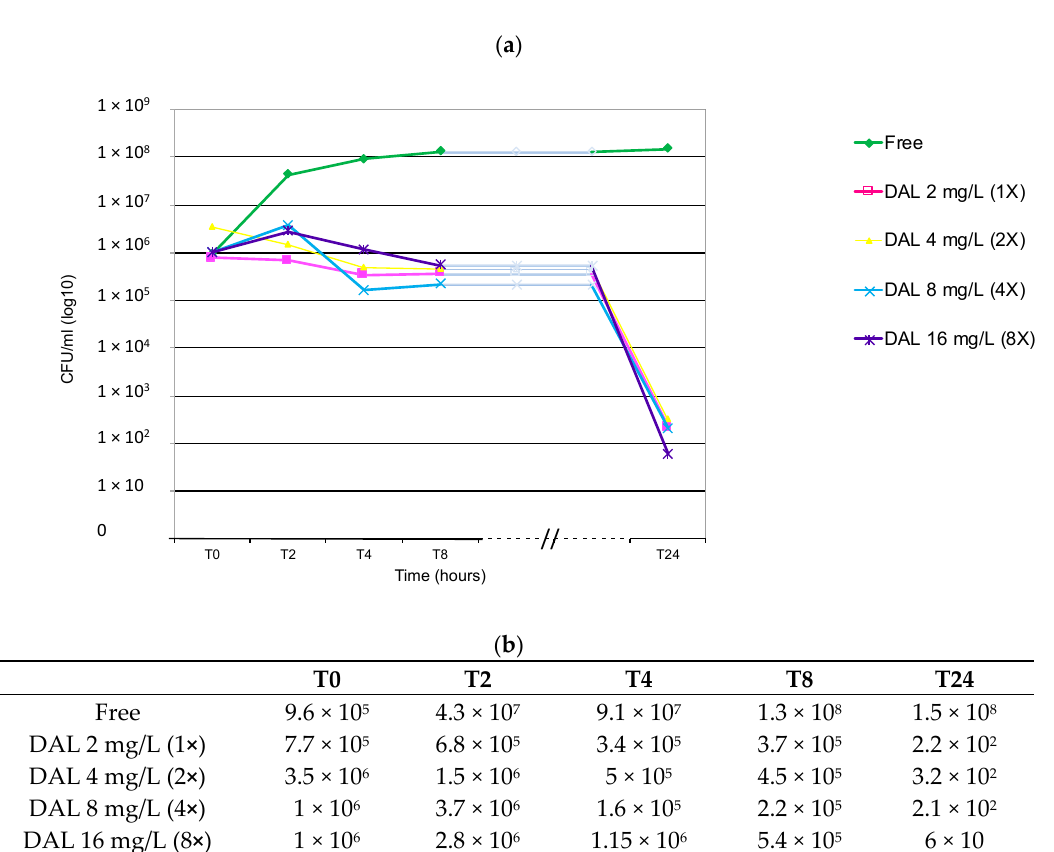
Figure 3. MRSA DNS ST1-IV-t386 MIC (1X) 2 mg/L. ( a ) Graph of curves obtained. ( b ) Average of duplicate viable counts (CFU/mL) observed at T0-T2-T4-T8 and T24 time intervals and after exposure to different concertation of dalbavancin (1-2-4 and 8X MIC). DAL: dalbavancin. Time (hour): 0, 2, 4, 8 and 24 h after the starting inoculum . The red row represents the threshold of bactericidal activity ( ≥ 3 log 10 decrease).